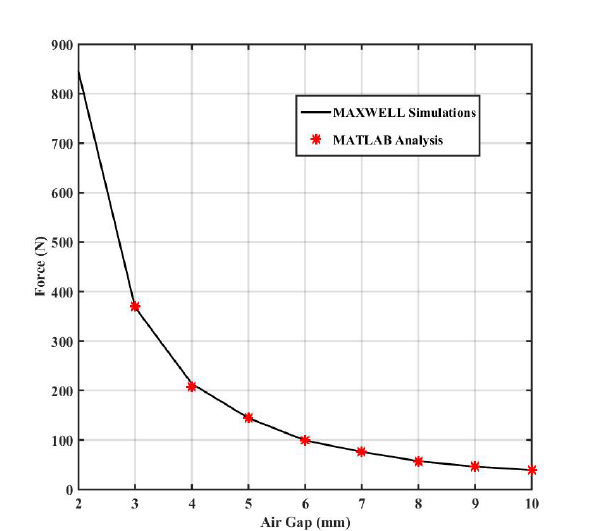
Figure 7: Variations of lifting force with length of the air gap